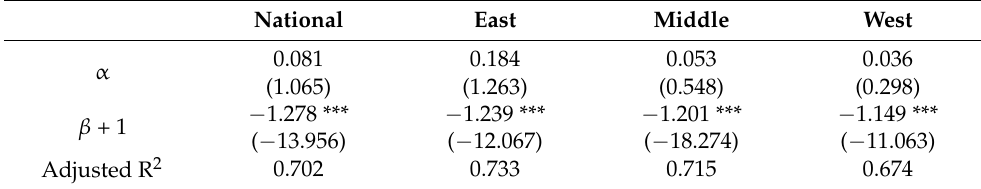
Table 8. Conditional β convergence test for land-element